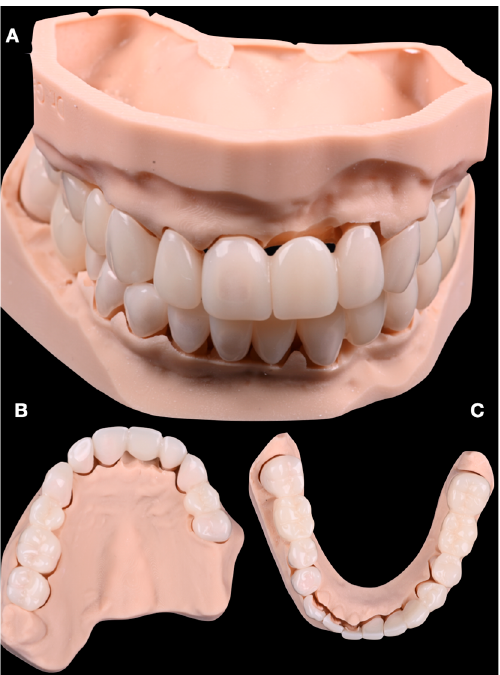
Figure 7. Milled provisional restorations on printed models. ( A ) Frontal view in occlusion. ( B ) Maxillary occlusal view. ( C ) Mandibular occlusal view.